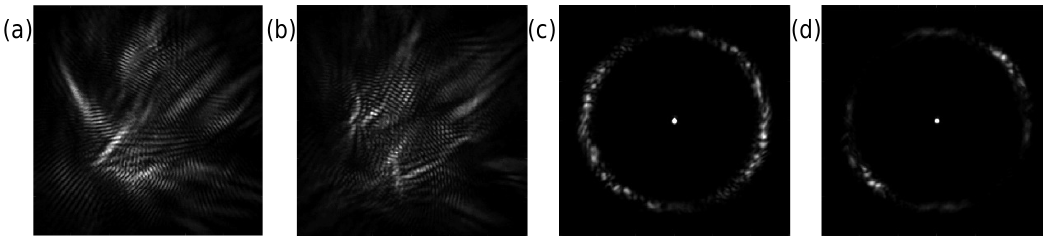
Figure 12. Example for coherence-based structure detected in channel perpendicular to input polarization. ( a , b ): Near field intensity structures. ( c , d ): Far field intensity displaying Fourier spectrum (not obtained in same realizations as in ( a , b )). Parameters: pump intensity 7 mW/cm 2 , detuning ∆ = − 12 Γ , b 0 = 110. The field of view is 4.4 mm for the NF and 16 mrad for the FF images.